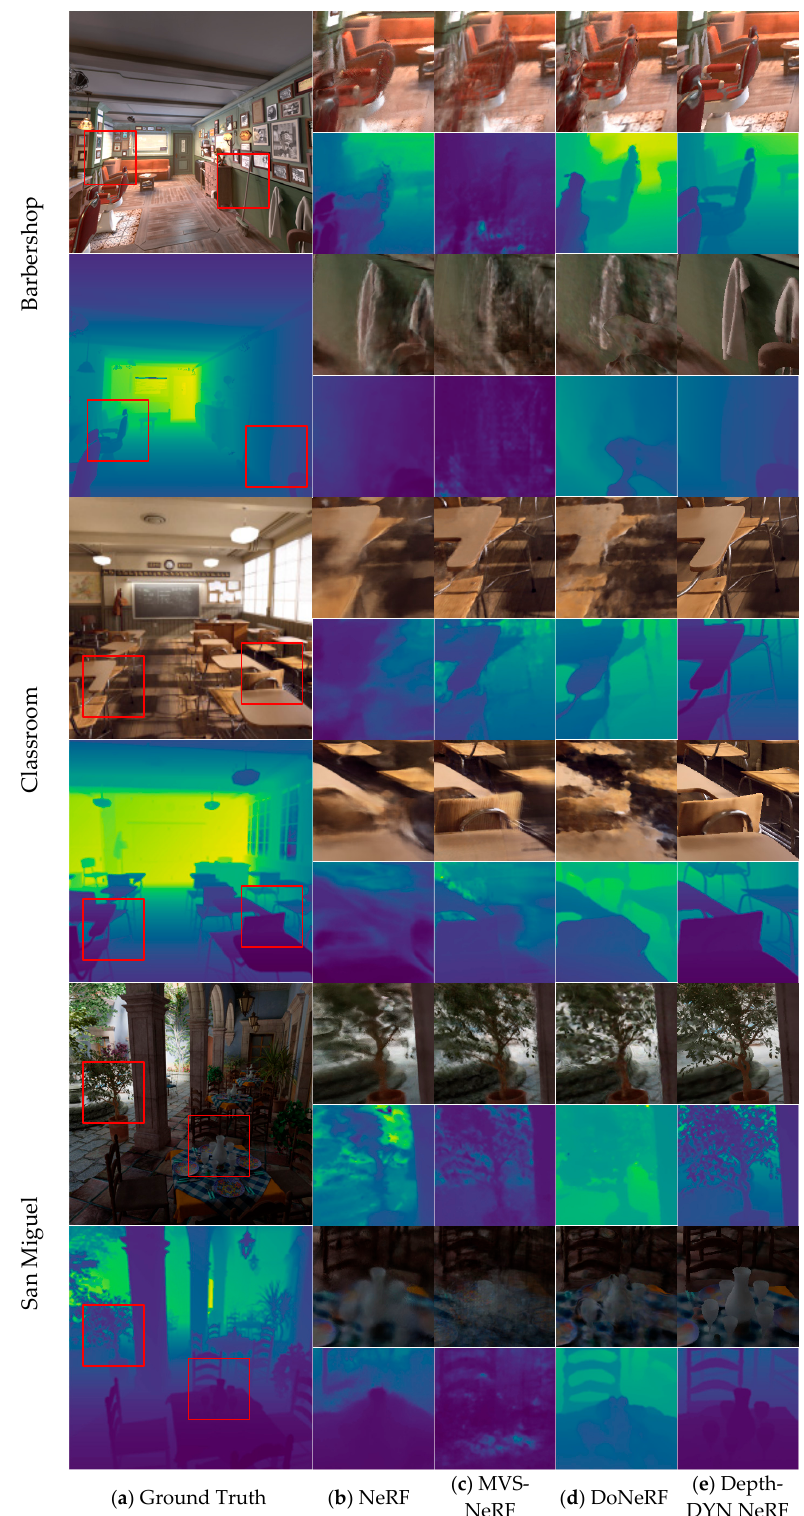
Figure 8. Rendered images and depths of the three test scenes vs. real images and depths.